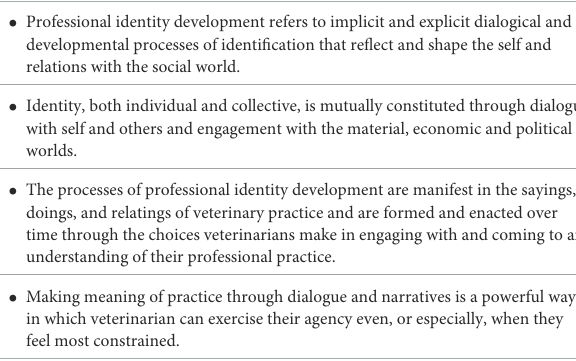
TABLE 2 A narrative conceptual framework for professional